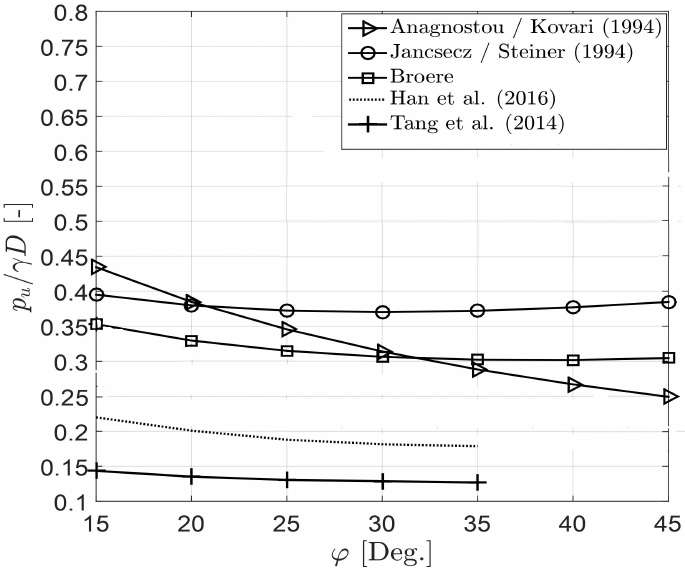
Figure 11. Minimum support pressure as a function of different friction